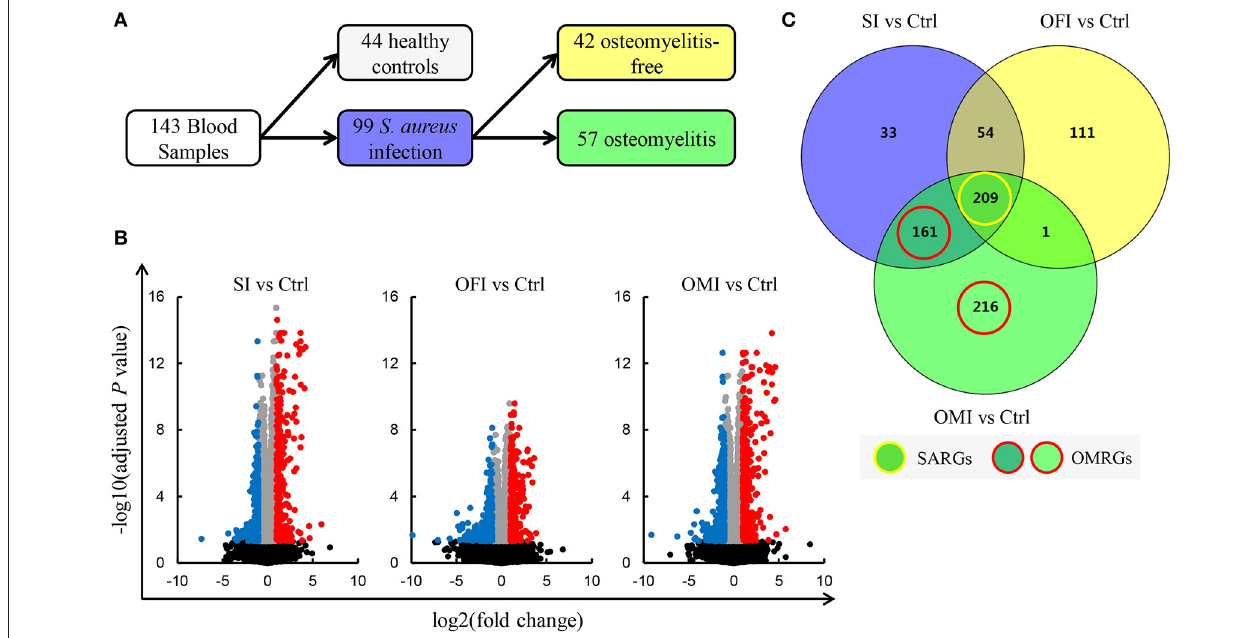
FIGURE 1 | Identification of DEGs. (A) Blood samples schematic. (B) Volcano plots for DEGs. Plots of –log10(adjusted P -value) vs. log2(fold change) for SI vs. Ctrl, OFI vs. Ctrl, and OMI vs. Ctrl. Red plots represent the upregulated genes and blue plots represent the downregulated genes. (C) Venn diagram of DEGs, SARGs, and OMRGs. Yellow circle means the SARGs and red circle means the